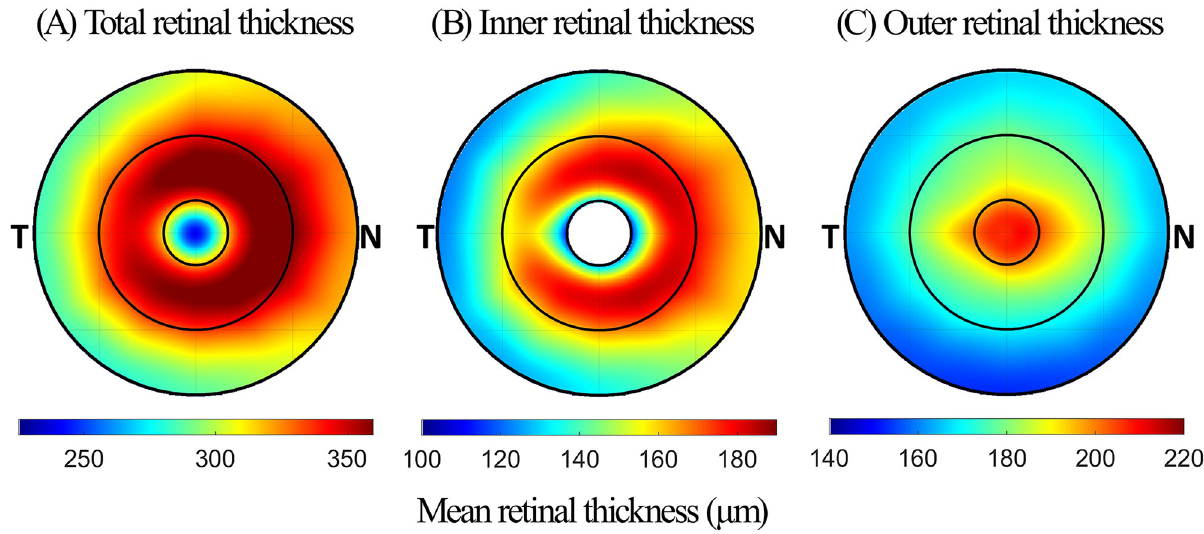
Fig 2. Thickness maps illustrating the average thickness of (A) the total retina, (B) the inner retinal layers, and (C) the outer retinal layers, across a 5 mm zone.